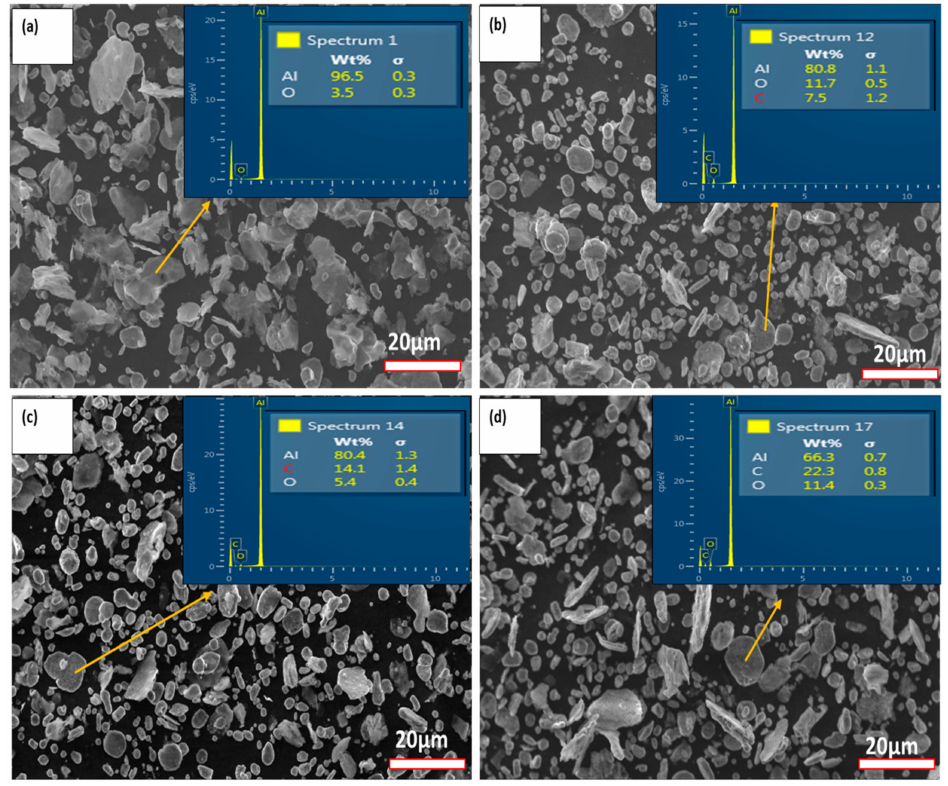
Figure 8. SEM micrographs of the pure Al ( a ); GNPs/Al composite powder ( b ) 0.5 wt. %; ( c ) 1 wt. %; ( d ) 1.5 wt. % with respective EDS analysis.